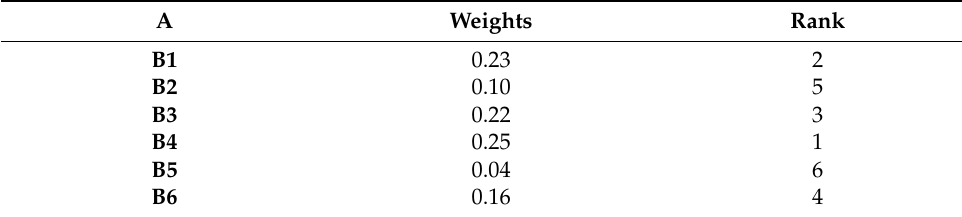
Table 6. Average weight of the indicator.